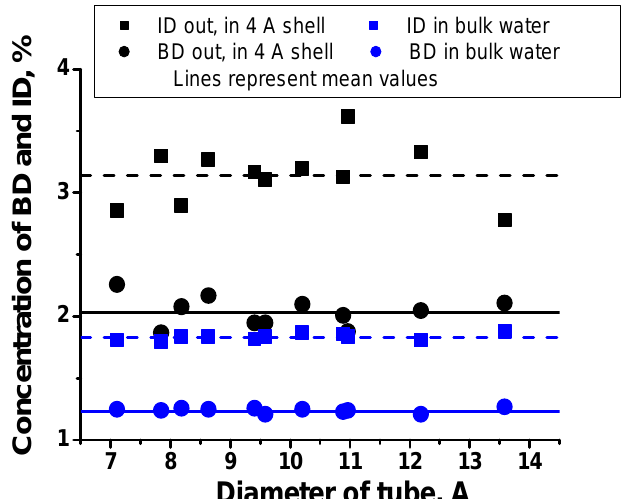
Figure 8. Dependencies of concentration of BD and ID in outer hydration shell and bulk water on the CN diameters.